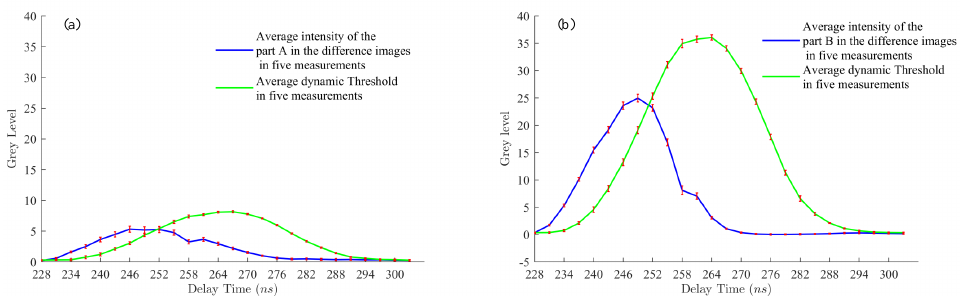
Figure 7. The averaged PSNR curve of the distance information obtained by the DTAFD method with different ε in five measurements.